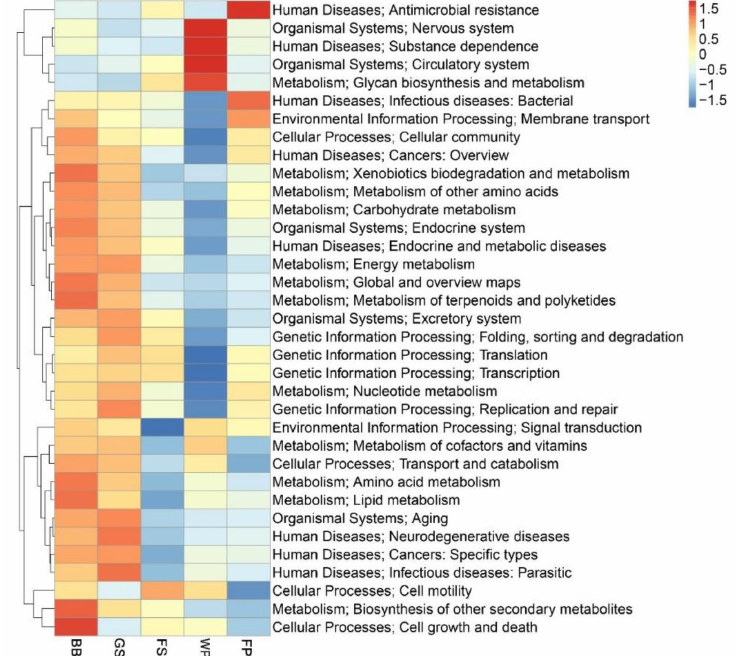
Figure 5. Annotated functional profile (KEGG level 2) of bioaerosols from five types of swine confinement buildings. BB, GS, FS, WP, and FP referred to bioaerosols collected from the piggeries that were exclusively housing breeding boars, gestating sows, farrowing sows, weaning piglets, and finishing pigs,